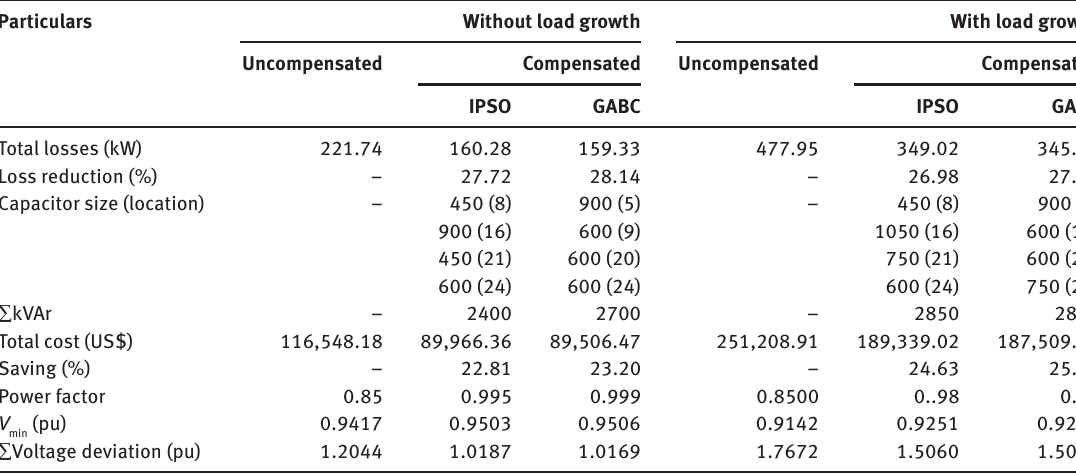
Table 3: Simulation Results of the 34-Bus Distribution Network after SC Placement Using the Proposed Approach.